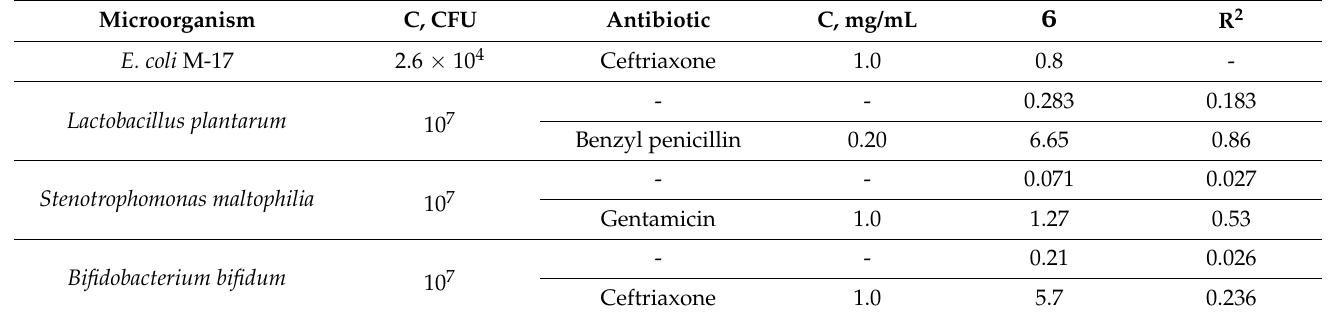
( c ) Figure 11. Registration of suspensions of microorganisms in a matrix chip using a 2D collimator ( a ) for the array of 20 measuring cuvettes, an optical scheme of the speckle excitation in microcells ( b ), where 1 – microorganism, 2 – cluster of microorganisms, and the speckle field of the cuvette of the E. coli M-17 filled in phosphate buffer ( c ), where the white circle indicates the signal reception aper- ture.